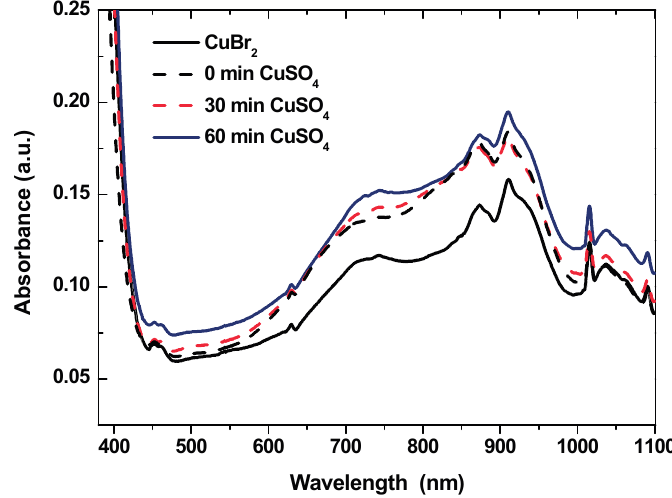
Figure 2. UV-vis spectra of CuSO 4 ·5H 2 O/TPMA complex in DMSO before irradiation and after 30 and 60 min of irradiation at λ > 350 nm and UV-vis spectrum of CuBr 2 /TPMA complex.